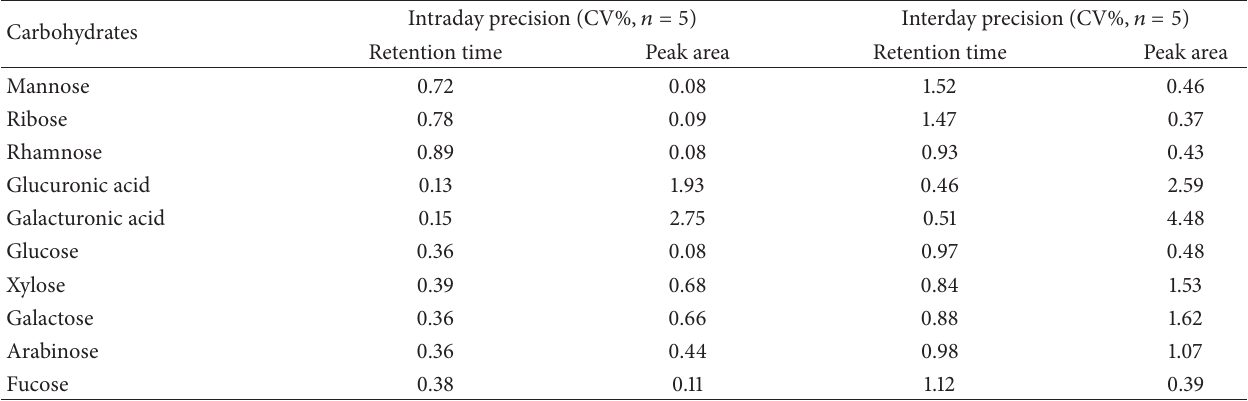
Table 2: Intraday and interday precision of the pre-column PMP derivatization HPLC method in terms of the retention time and peak areas of the monosaccharide standards.